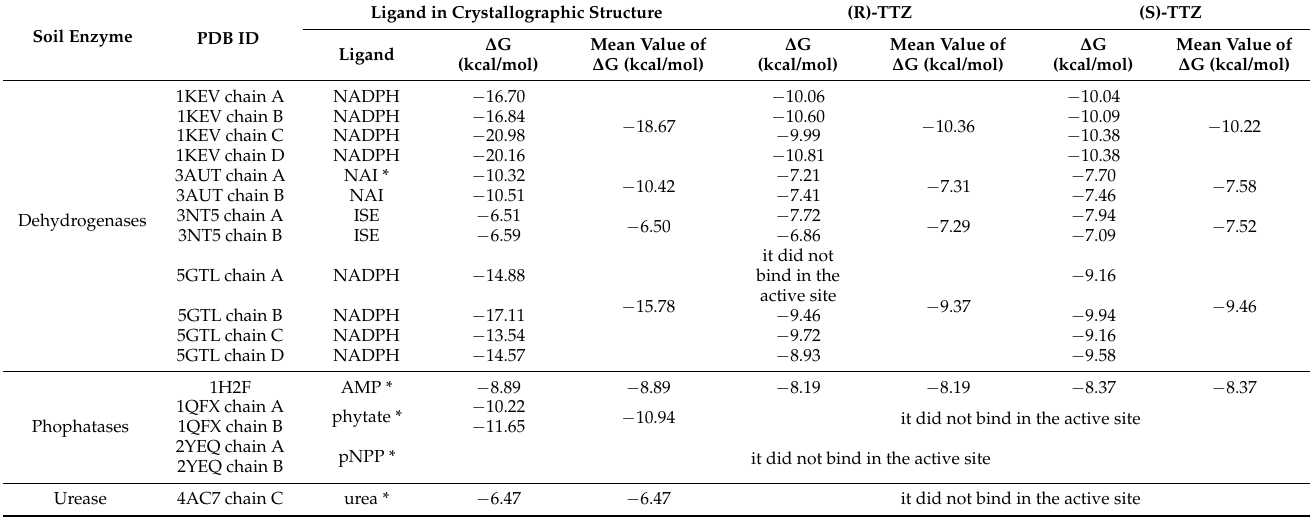
Table 2. Interaction energies ( ∆ G) between the stereoisomers of triticonazole (TTZ) and soil enzymes for the best docking poses corresponding to the active sites of enzymes. This table also contains the interacting energies obtained for the docking of the ligands that were present in the crystallographic structures of the investigated enzymes: NADPH—dihydro-nicotinamide-adenine-dinucleotide phos-